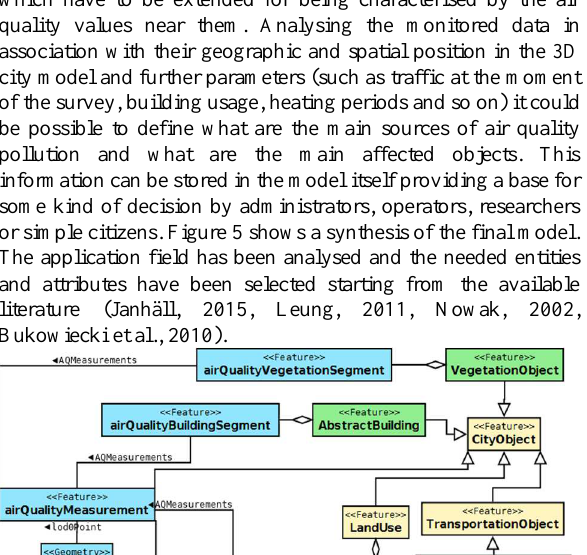
Figure 3. Ground level dust in the long distance.